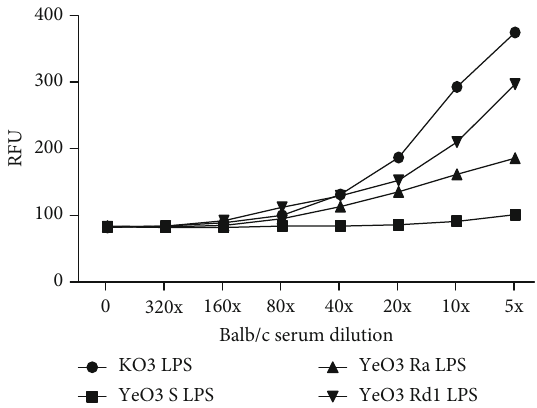
Figure 5: Activation of murine MASP-1 serine protease by tested LPS.